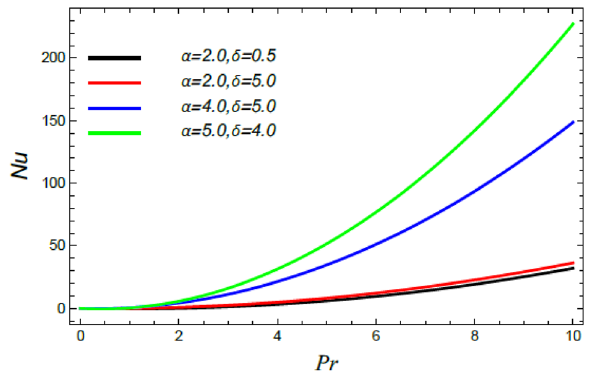
Figure 30. Nusselt numeral versus Pr as given in Eq. (37) to illustrate the impact of the stretching factor α and the slip parameter δ .